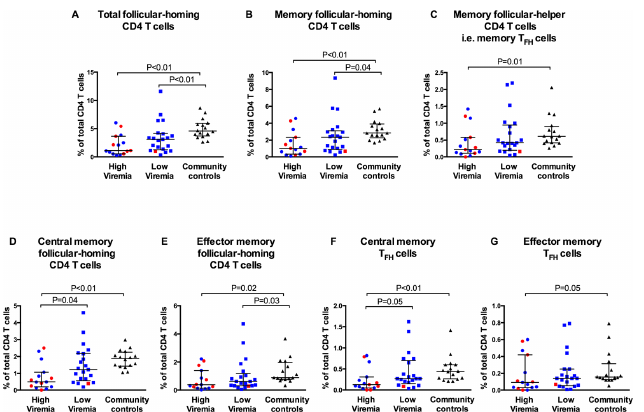
follicular-homingCD4 T cells (CXCR5 + CD45RO + CCR7 + CD4 + ), (E) effector memory follicular-homing CD4 T cells (CXCR5 + CD45RO + CCR7 - CD4 + ), (F) central memory T FH cells (CXCR5 + CD45RO + PD1 + CCR7 + CD4 + ) and (G) effector memory T FH cells(CXCR5 + CD45RO + PD1 + CCR7 - CD4 + ) as percentages of total CD4 T cells. Each symbolrepresents a child. High viremia, (cid:21) 5000 RNA copies/ml; Low viremia, < 5000RNA copies/ml. Horizontal lines and error bars representmedian,25 th and 75 th percentiles. Red symbolsrepresentHIV- infectedchildrenwho were not on HAART. Blue symbols representHAART-treated children.Statisticaltest: Wilcoxon’s rank sum